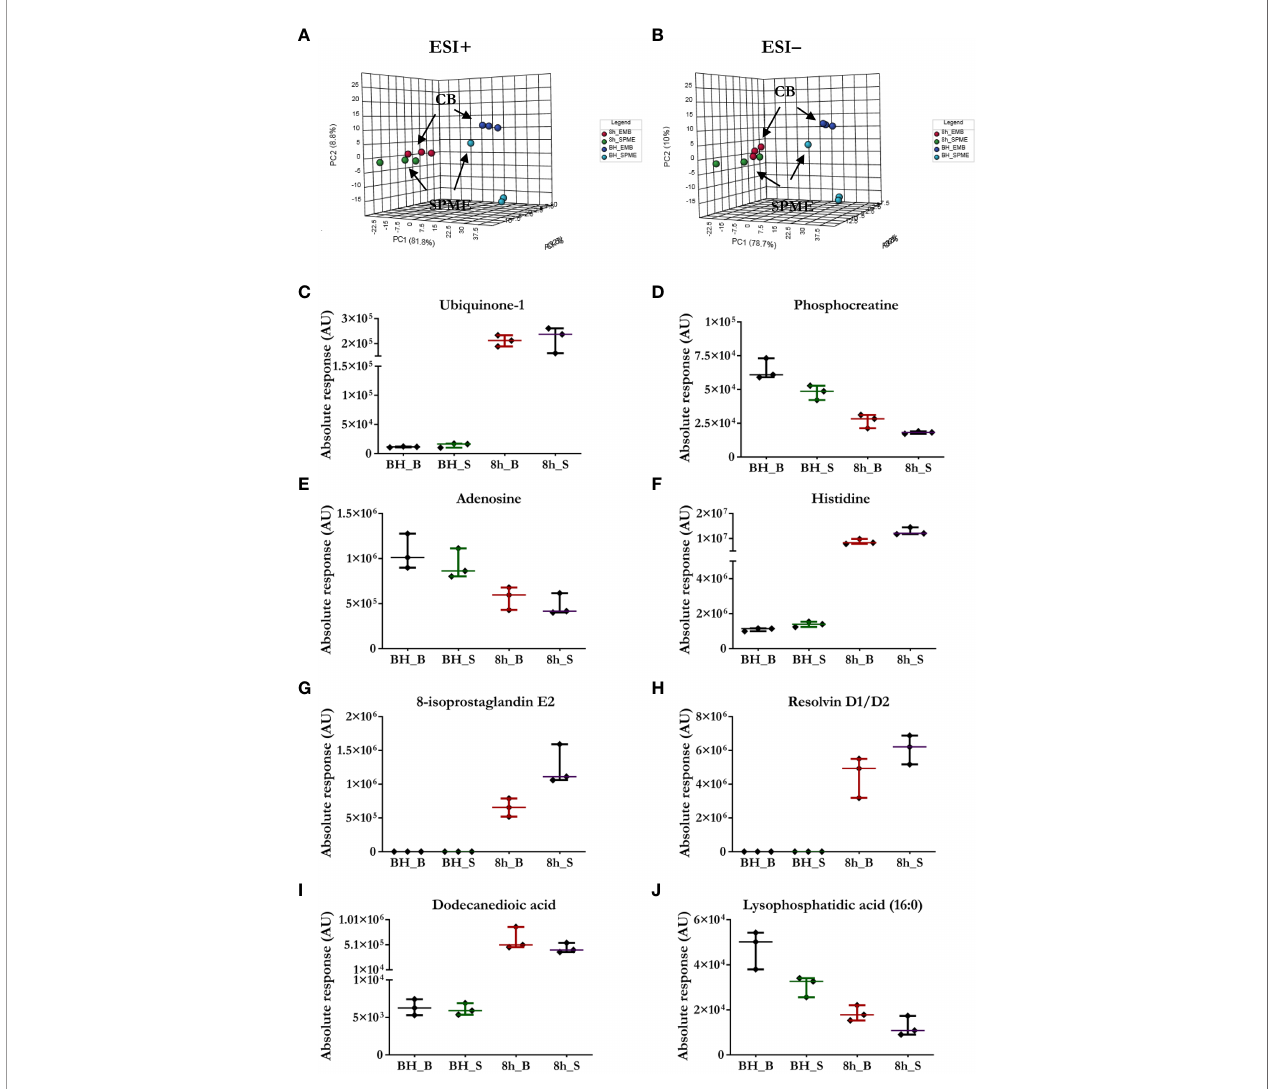
FIGURE 2 | Comparison of the performance of our newly developed sampling method and a standard biopsy-collection method. (A, B) The principal component analysis (PCA) for metabolic features detected in SPME or biopsy samples (CB) implies relative agreement between both approaches. Light blue — in vivo LV (left ventricle) SPME samples; dark blue — in vivo LV biopsy samples; green — SPME samples taken at 8 h of ESHP; red — biopsy samples collected at 8 h of ESHP. (C – J) Scatter plots showing relative intensities for selected metabolic features attained using the two sampling methods. Each dot in the scatter plots represents an individual metabolite/lipid in each sample. BH_B/S — in vivo LV biopsy/SPME samples; 8h_B/S — 8 h ESHP biopsy/SPME